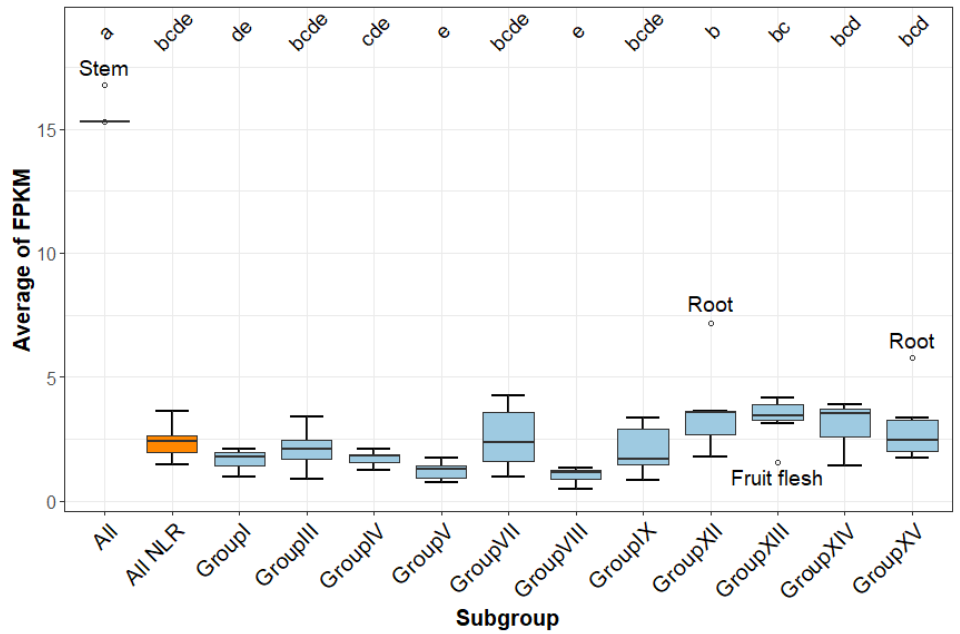
Figure 5. The NLRs were little expressed in various tissue types under normal growth condition. The mean FPKM (Fragments Per Kilobase of exon model per Million mapped fragments) value of each group. An ANOVA showed significant differences of the mean FPKM values among the tissues. The TukeyHSD test was used to determine differences between groups and marked by level of significance (a – e).